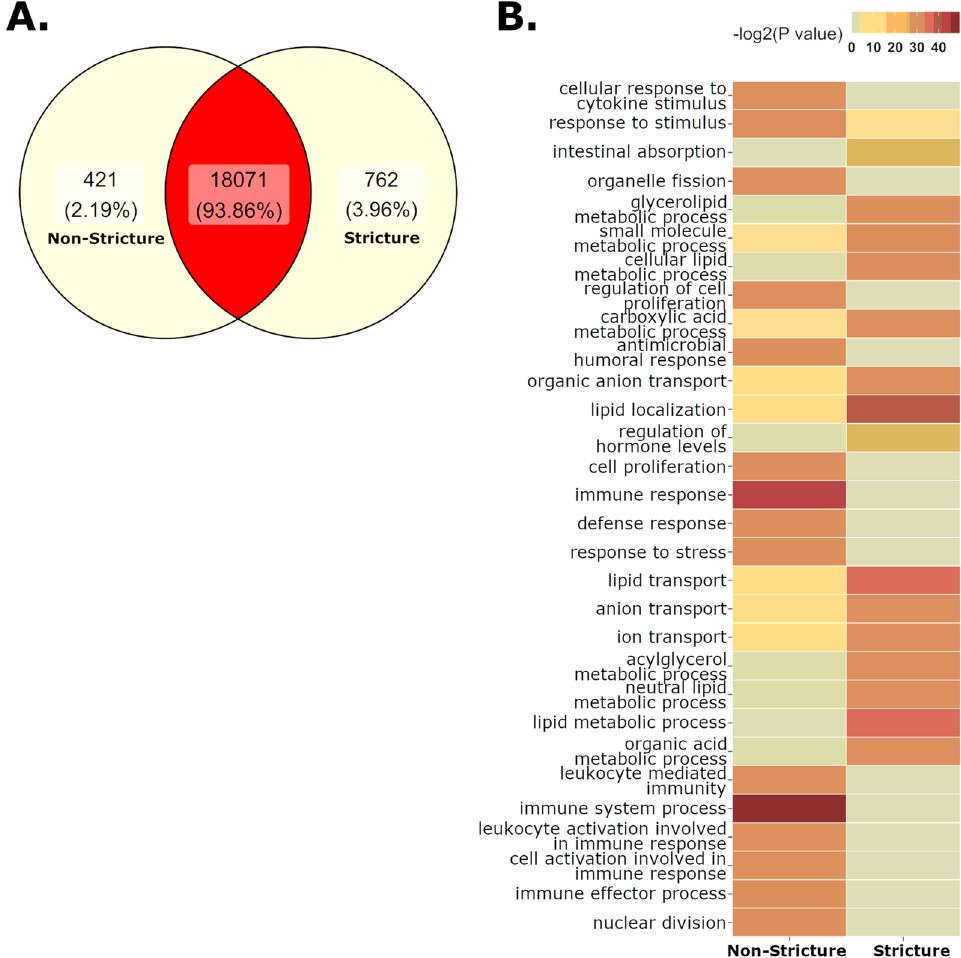
Figure 5. ( A ) Differentially expressed genes (DEG) (FDR < 0.05) in the duodenum of non-stricture and stricture cases. ( B ) Gene ontology (GO) sets enriched in stricture cases show upregulation of lipid metabolism, transport and localization. Non-stricture cases have enrichment of immune processes, possibly due to underlying pathology in necropsied animals with non-stricture